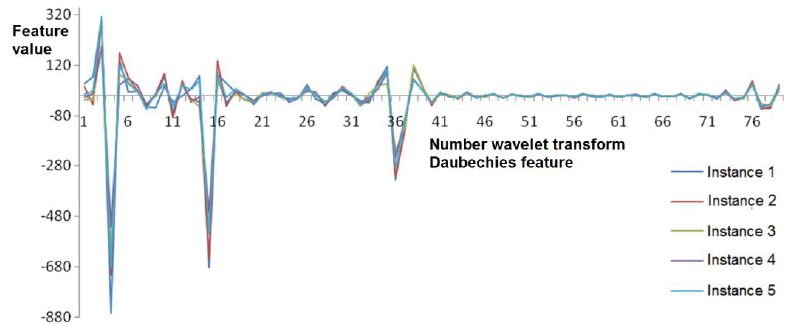
Figure 2. Wavelet transform coefficients scaled by the pen pressure function (onto a tablet) to the mean length of a signature instance for a signer.